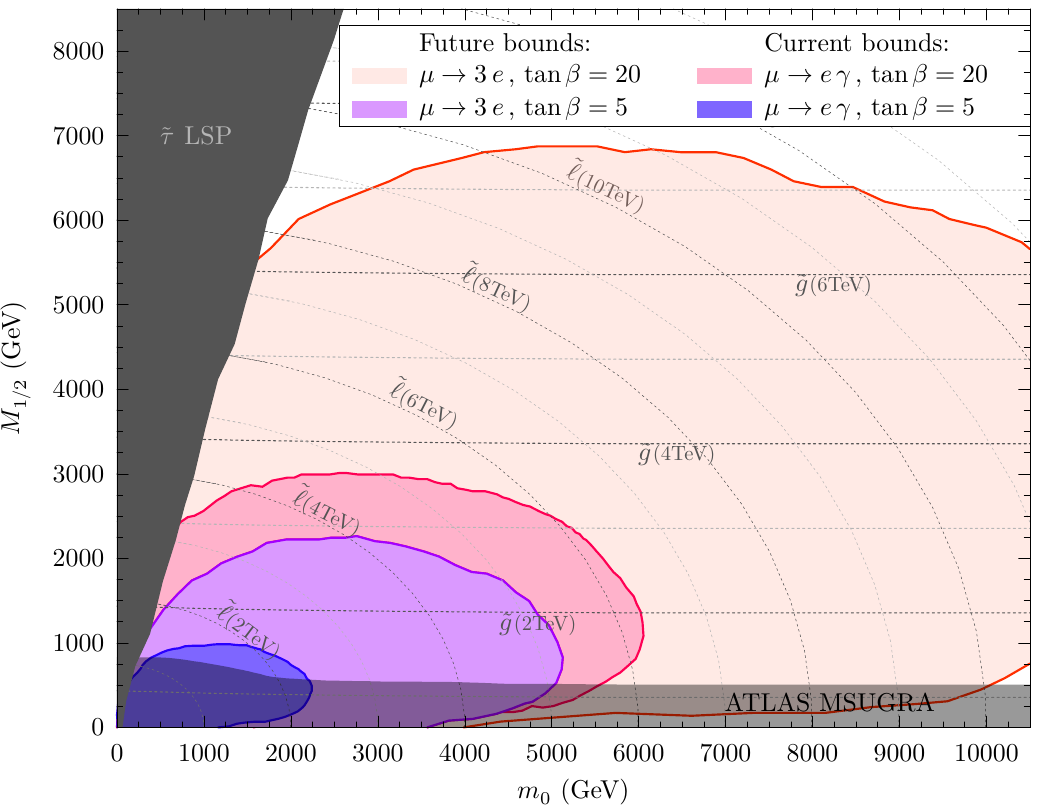
Figure 7 . Excluded regions due to (cid:22) ! e(cid:13) and (cid:22) ! eee for two reference values: tan (cid:12) = 5 (blue shapes) and tan (cid:12) = 20 (red shapes). In the dark (blue and red) regions, we compare with current (cid:22) ! e(cid:13) bounds, while in the light (blue and red) regions we compare with the expected (cid:22) ! eee sensitivity in the near future. As before, these results are competitive with mSUGRA ATLAS limits (gray